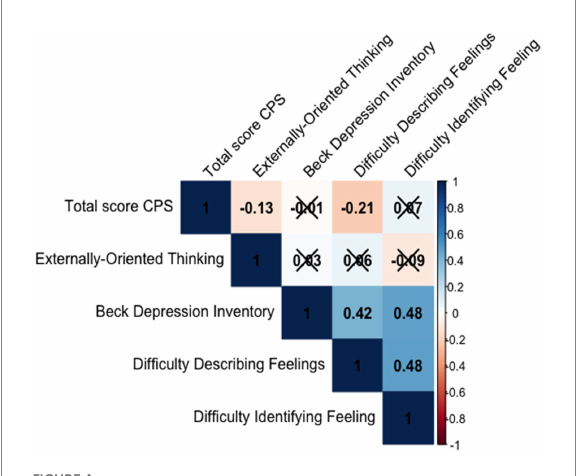
FIGURE 4 Correlation indicating SSC convergent and divergent validity. Non-significant correlations are marked with an X.